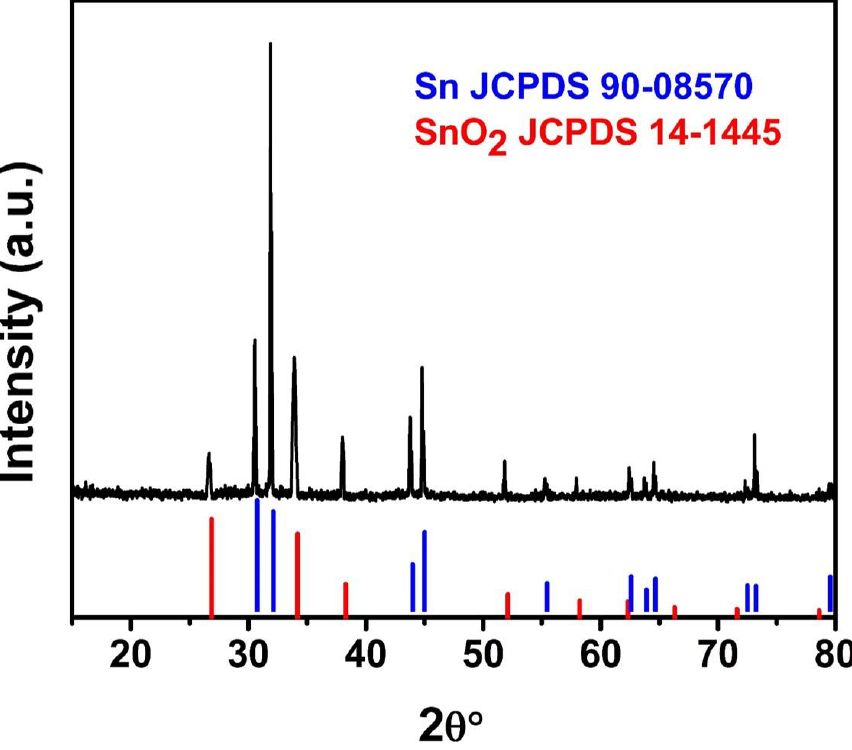
Figure 1. XRD pattern of Sn/SnO 2 /C.